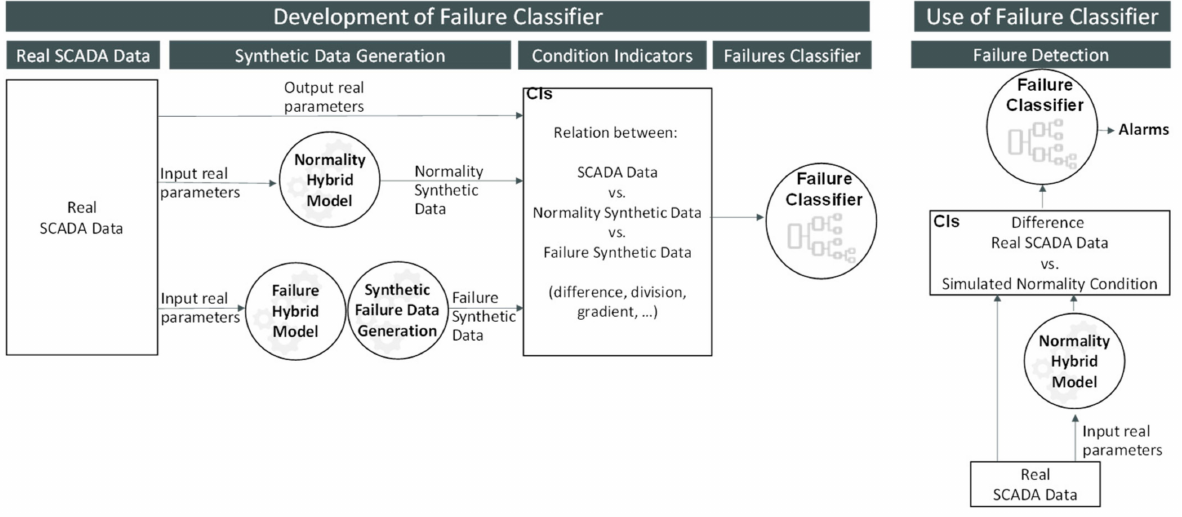
Figure 1. Methodology illustration for the creation of a hybrid-model-based